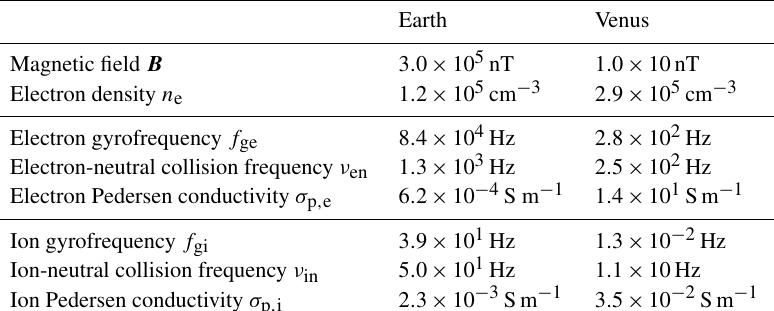
Table 2. Comparison of Pedersen conductivity estimate at the peak altitudes of the conductivity; z = 130km on Earth and z = 150km on Venus. Electron density value on Earth is taken from Kelly (1989) at z = 130km. Electron density value on Venus is from Kilore and Luhmann (1991) during the solar maximum at an altitude of z = 150km (at the peak of Pedersen conductivity). Electron gyrofrequency is calculated from the nominal magnetic field magnitude. Collision frequency values on Earth are from Kertz (1989) and those on Venus are from Dubinin et al. (2014). A mean mass ratio of 11 . 6 is used between the ions and the protons.